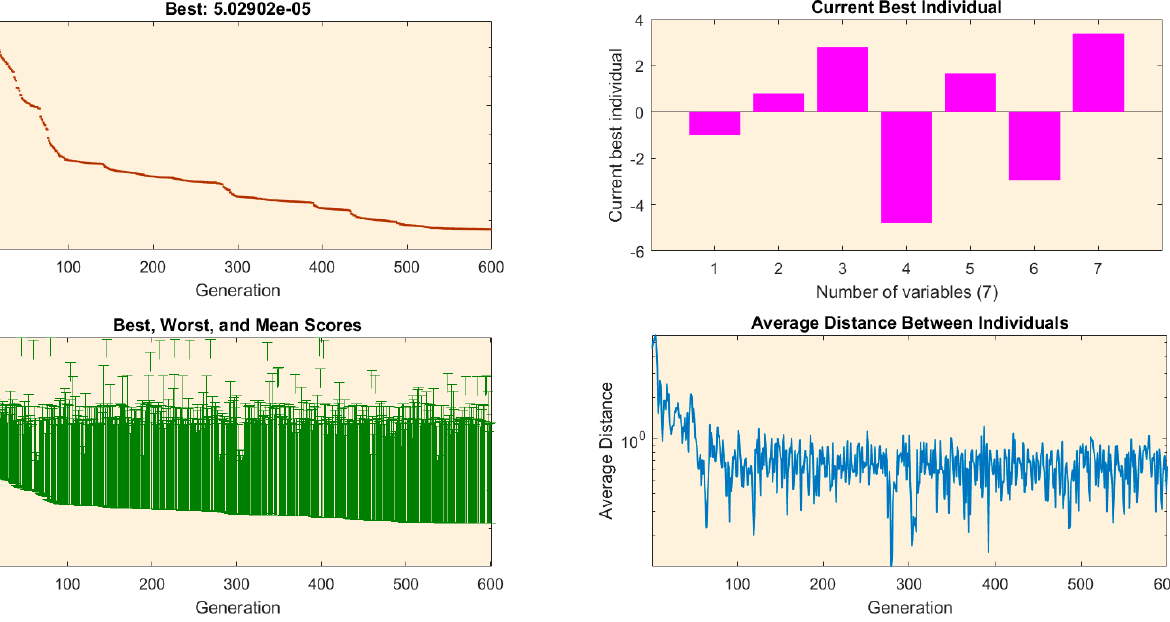
Figure 10. Results of Problem 2 in terms of learning curve, best individual scores, and average distance for 0 noise level.